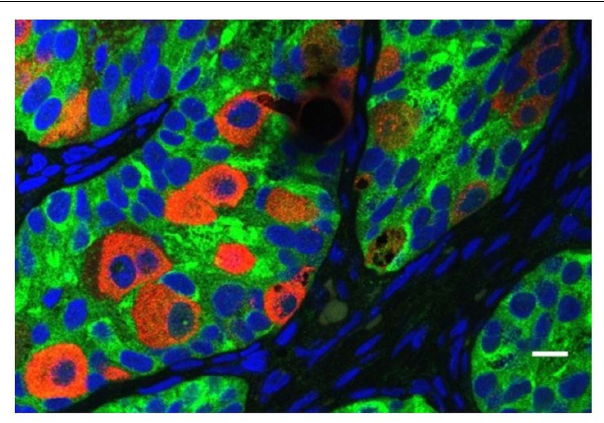
FIGURE 6 |Abnormal persistence of gonocytes beyond 6 months of age in a boy with cryptorchidism. The germ cells are labeled with MVH (mouse homolog of DrosophilaVasa), and the Sertoli cells are labeled with MIS/AMH (bar = 10 μ